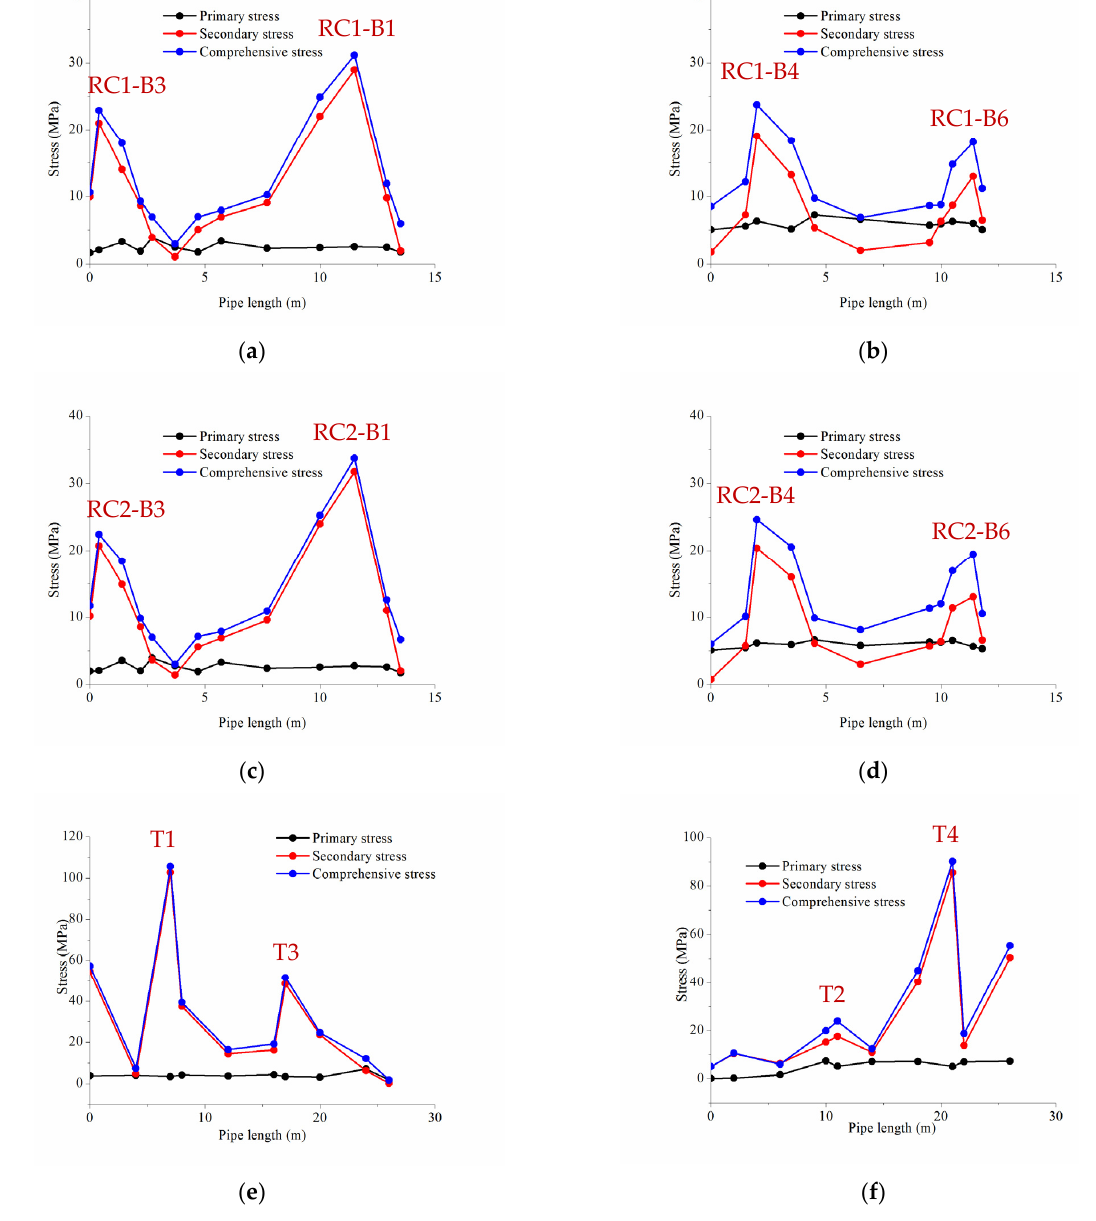
Figure 10. Stress distribution: ( a ) Compressor (RC1) inlet pipe; ( b ) Compressor (RC1) outlet pipe; ( c ) Compressor (RC2) inlet pipe; ( d ) Compressor (RC2) outlet pipe; ( e ) Main suction pipe; ( f ) Main exhaust pipe.